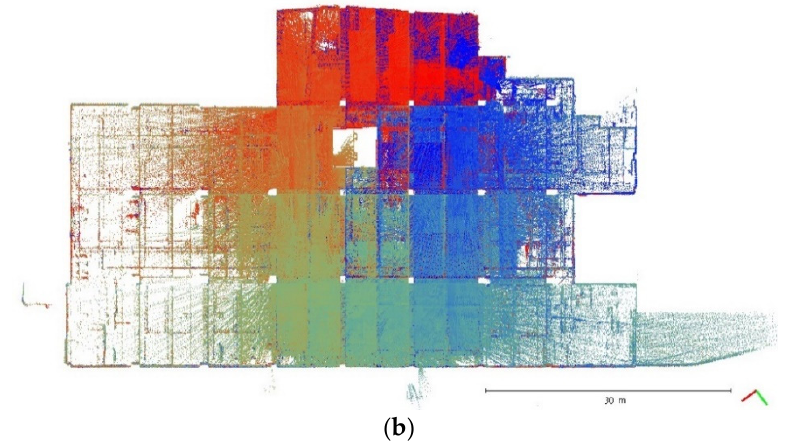
Figure 6. The top view of calibration dataset DATA2. ( a ) Point cloud colored by SLAM condition; ( b ) Point cloud colored by scanning time.